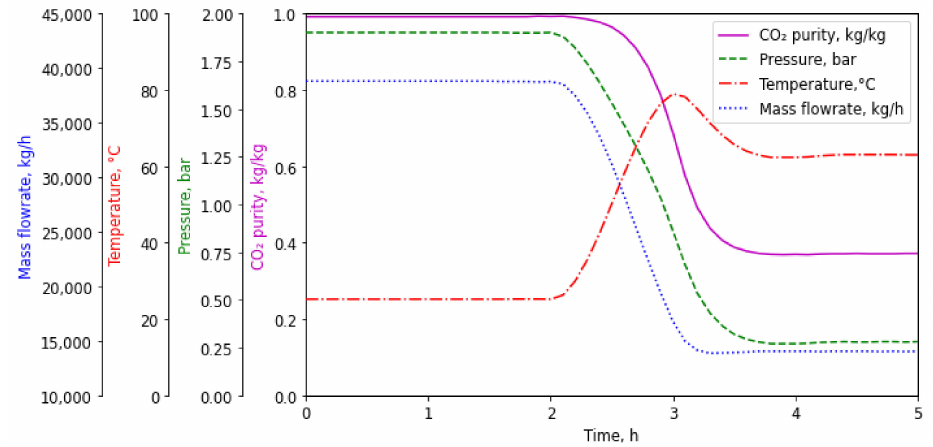
Figure 4. Stripper response to 10% in flue gas flow rate in open-loop